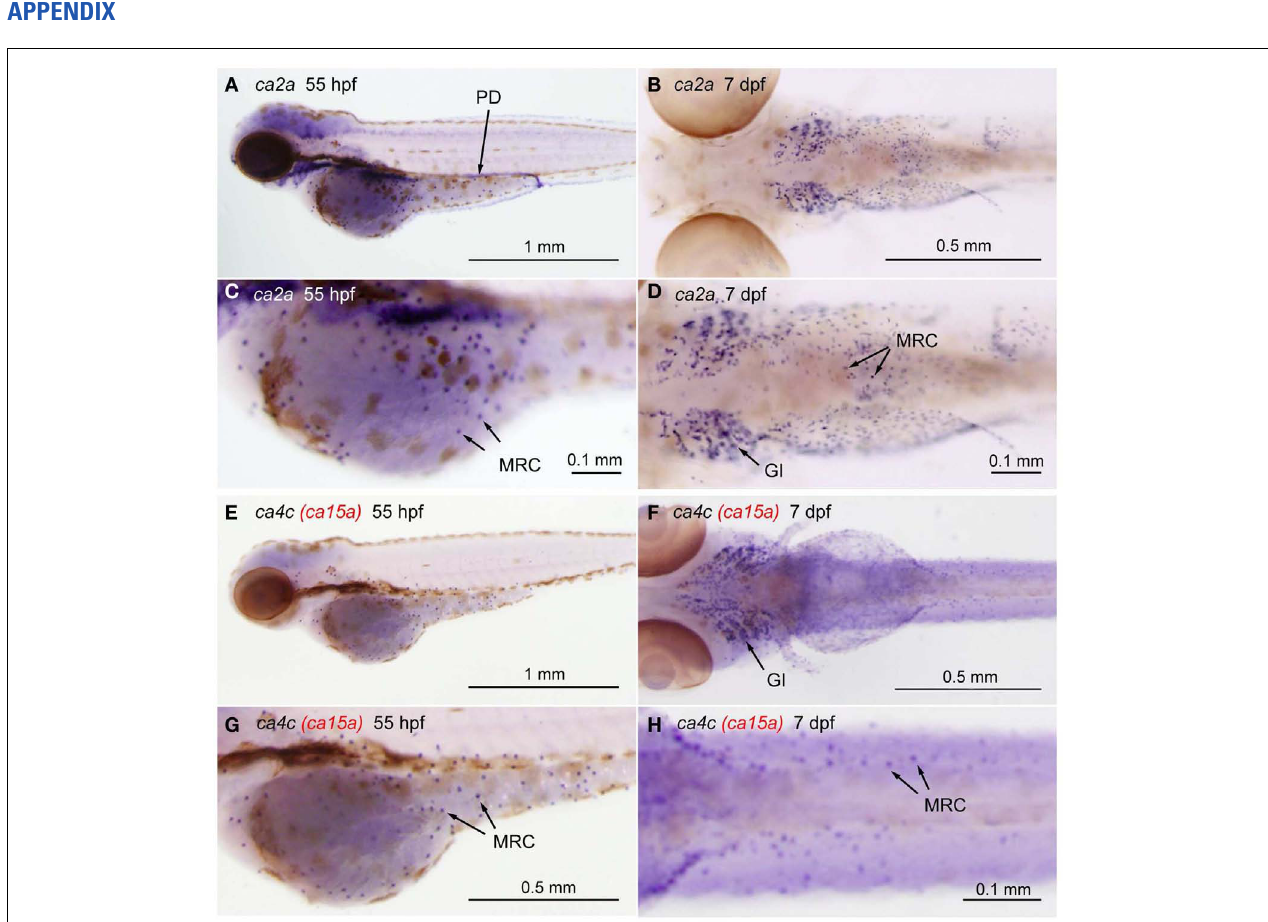
background as it was observed with sense cRNA probes. Four CA4 isoforms predicted from zebrafish database showed different tissue-specific distribution. ca4a , most homologus to mammalian CA IV , is expressed in the pancreas and expected to be involved in the regulation of the luminal pH of the pancreatic duct system (Fujikawa-Adachi et al., 1999).The other two isoforms ca4b and ca4d are expressed respectively in the posterior part and anterior part of the renal pronephric ducts.These expressions reminds that localization of mammalian membrane-bound CA in the proximal tubule cells and the intercalated cells of the collecting ducts, which is suggested to contribute to reabsorption of HCO − and regulation of acid-base balance of 3 urine (Dobyan and Bulger, 1982). Its location suggests a role in regenerating CO 2 , a substrate for CA II. For ca4c (i.e., ca15a ), see the